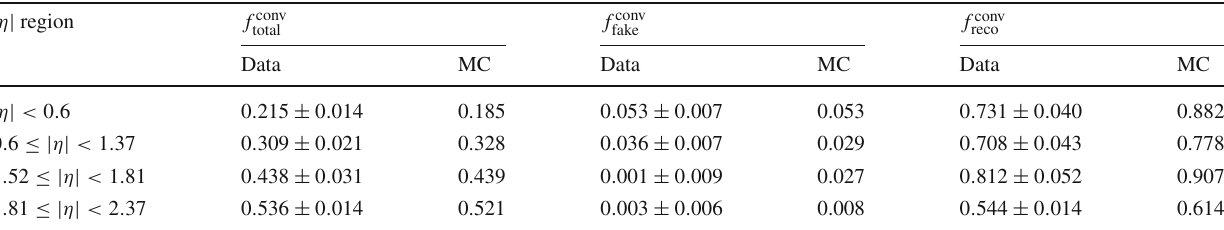
Table 2 Results from data and MC simulation of the f conv fraction the f conv reco probability for a true converted photon to be reconstructed as total of all photons that are reconstructed as converted, of the f conv converted, in bins of | η | fraction fake of true unconverted photons that are reconstructed as converted, and of f conv